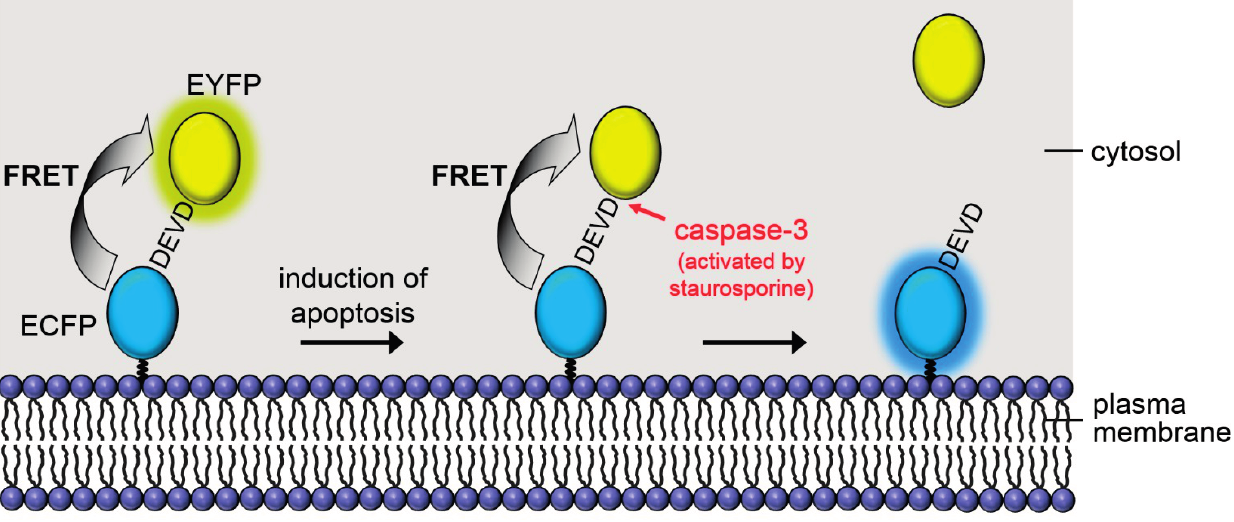
Figure 1. Cell membrane associated Förster Resonance Energy Transfer (FRET)-based sensor system for